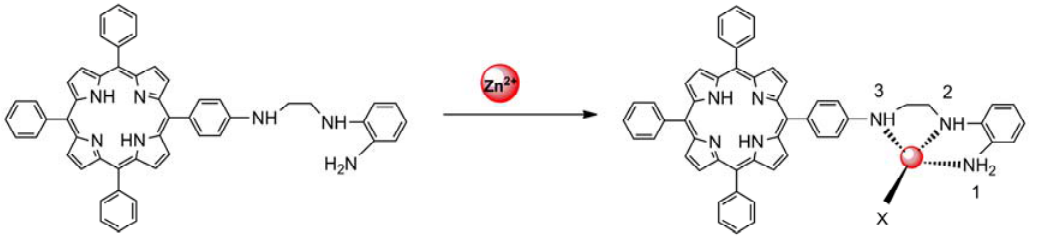
Figure 5. Fluorescence intensities of P1 (10 μ M) at 610 nm in the absence and presence of Zn 2+ (10 μ M) at various pH values, λ